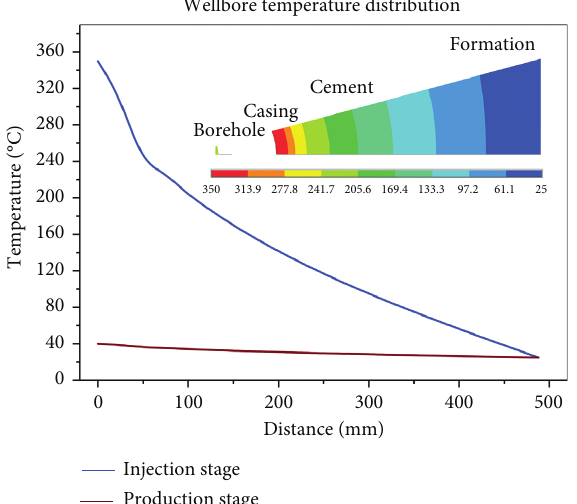
Figure 7: Wellbore temperature field